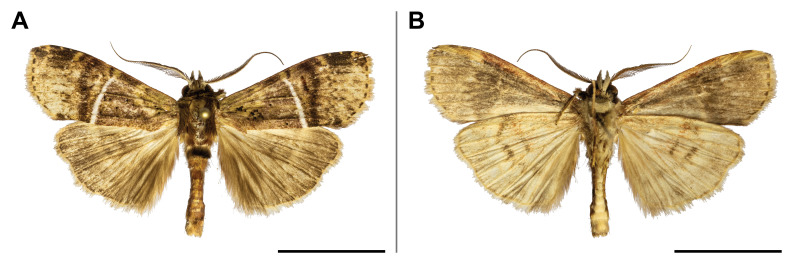
Gargettoscrancia
albolineata (Strand, 1912). A. dorsal view; B. ventral view. The scale bar represents 1 cm.